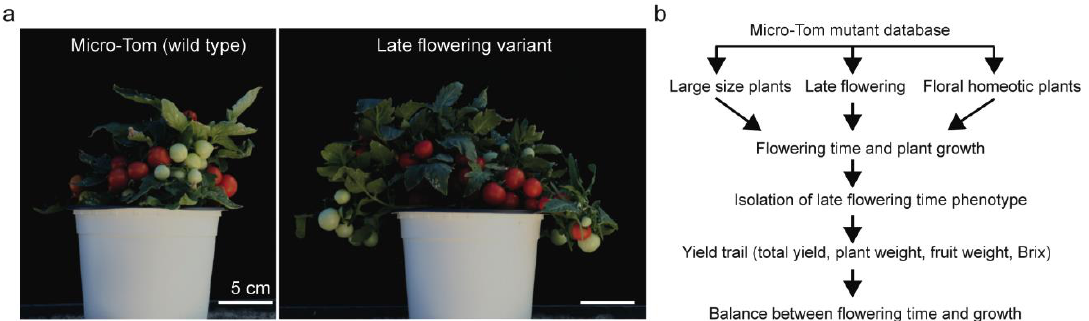
Figure 1. Strategy of fine-tuning optimal tomato yields through regulating flowering time and plant growth in tomato. ( a ) Representative plants with fruit set in wild type ( left ; Micro-Tom) and in weakly late-flowering mutant ( Right ). ( b ) The workflow followed to elucidate the relationship between plant weight, total yield, and other yield-related traits with flowering time variants.